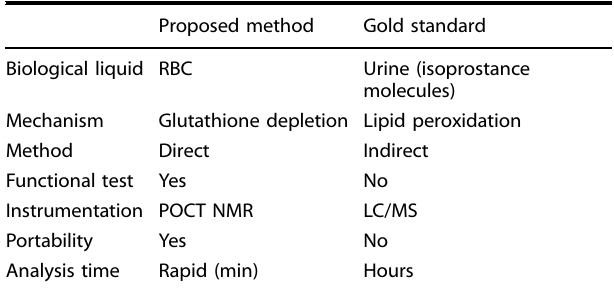
Table 2. Comparison of salient features between the proposed method (PoCT NMR) benchmarking against the gold standard, urinary F 2